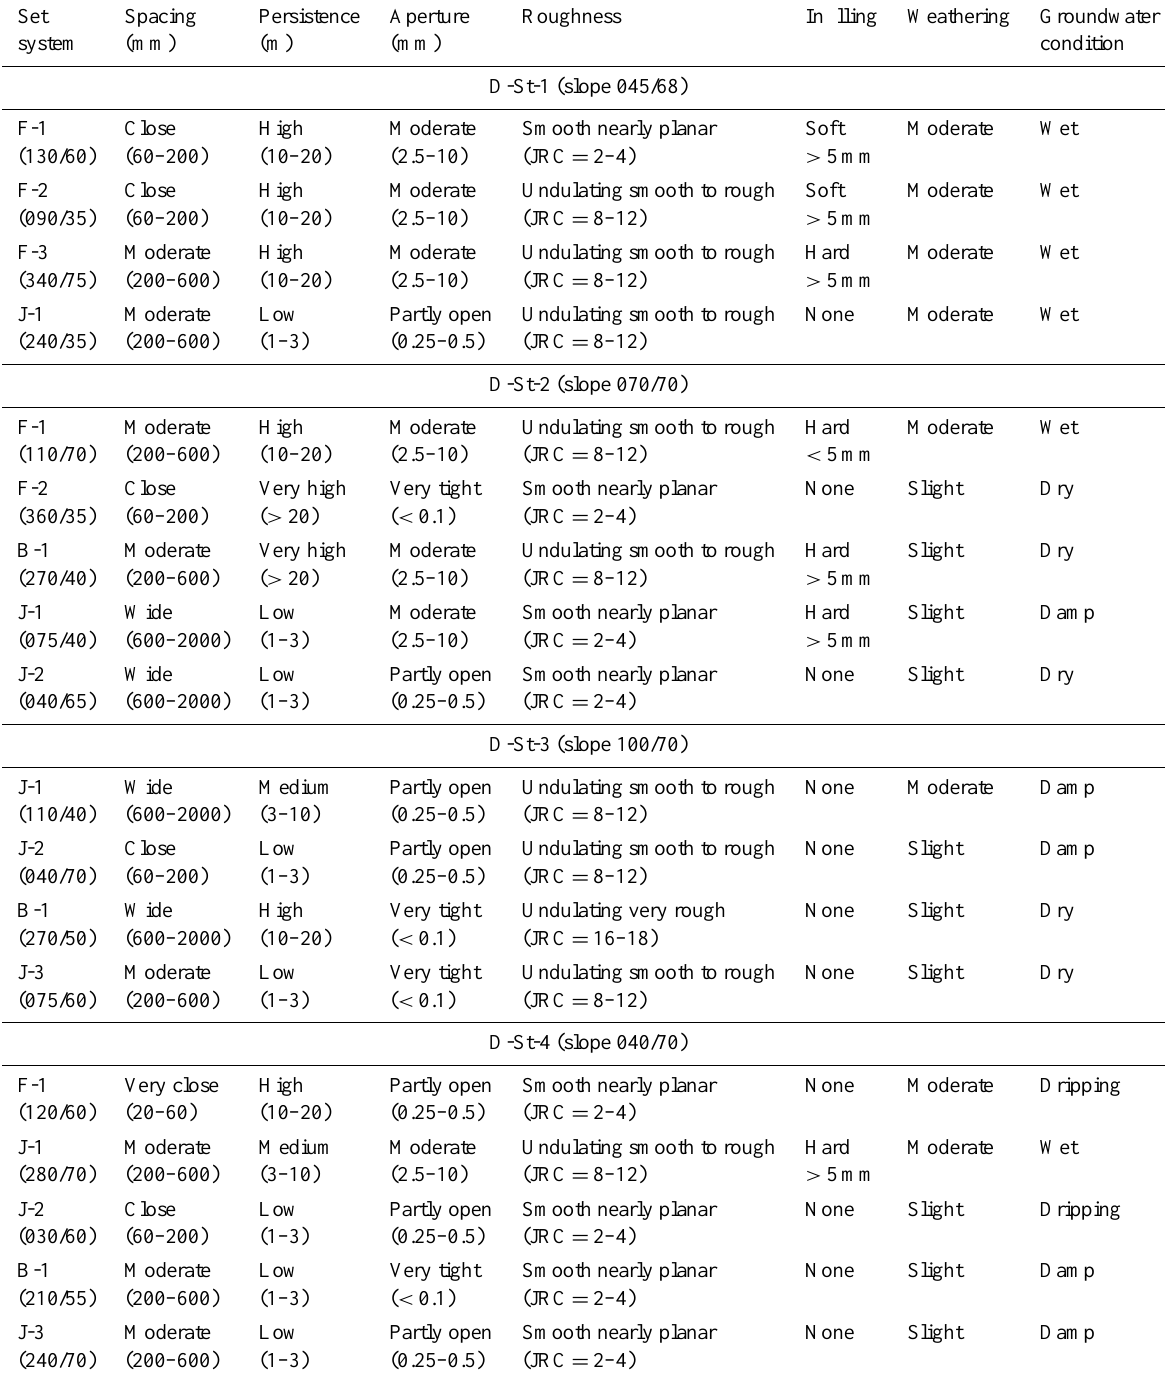
Table 1. Surveyed geostructural parameters. JRC: joint roughness